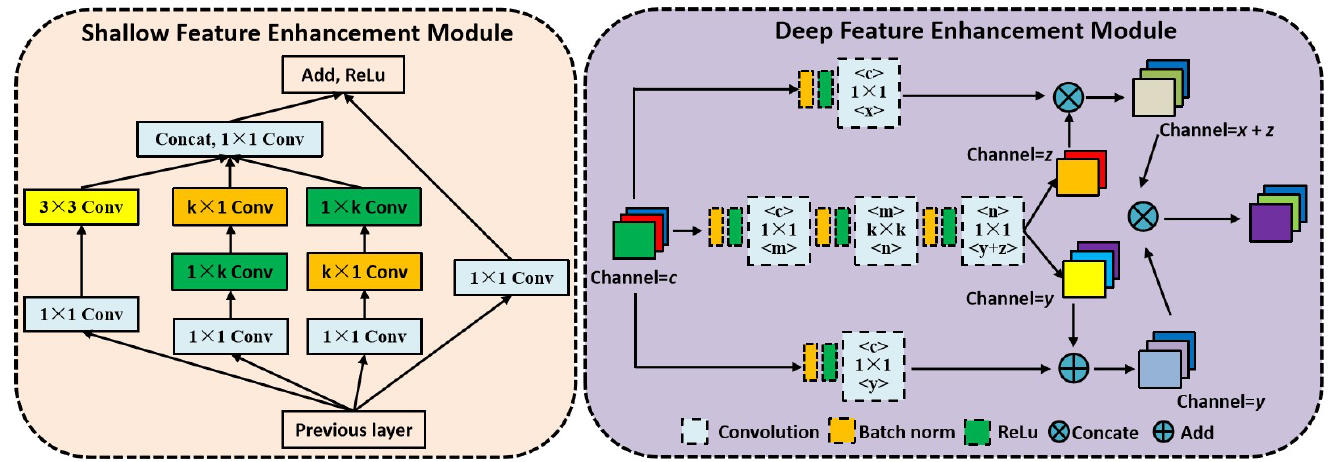
Figure 2. The structure of feature enhancement module, including the Shallow Feature Enhancement (SFE) Module and Deep Feature Enhancement (DFE)